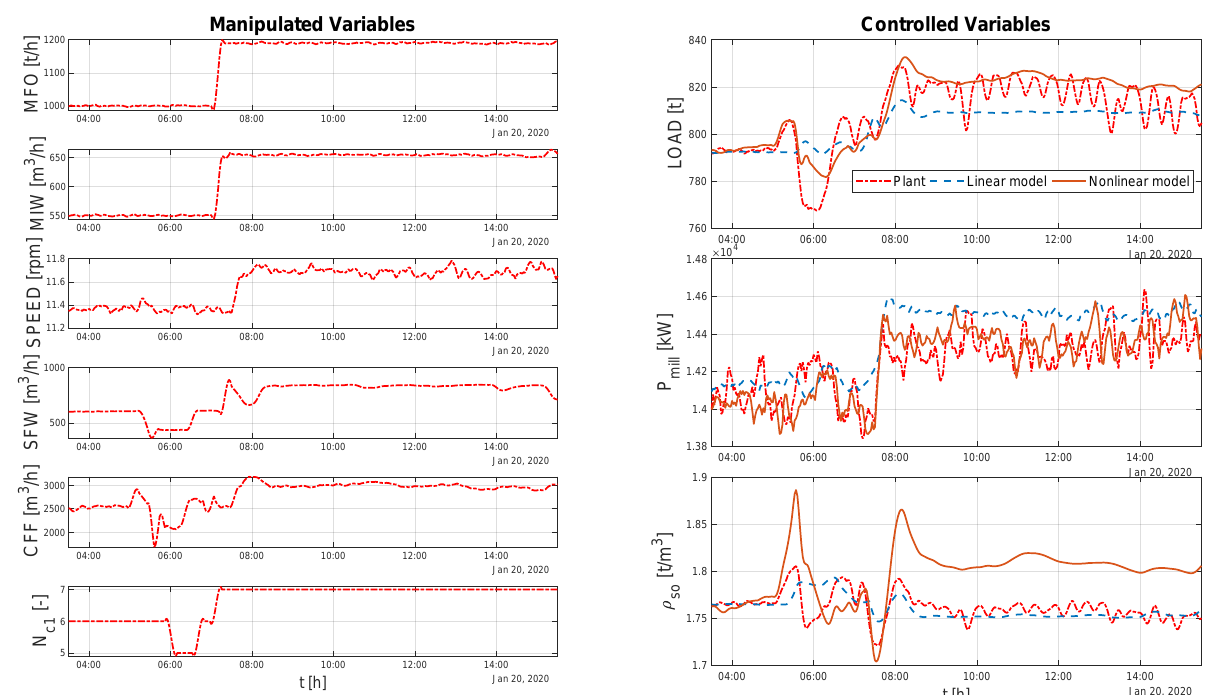
Figure 11. Comparison of the CV predictions using the linear and nonlinear models for a short section of DQA data. The results from modeling the planned step test data are used to compare the two models. The visual comparison of the predictions of the two models is shown in Figure 12.